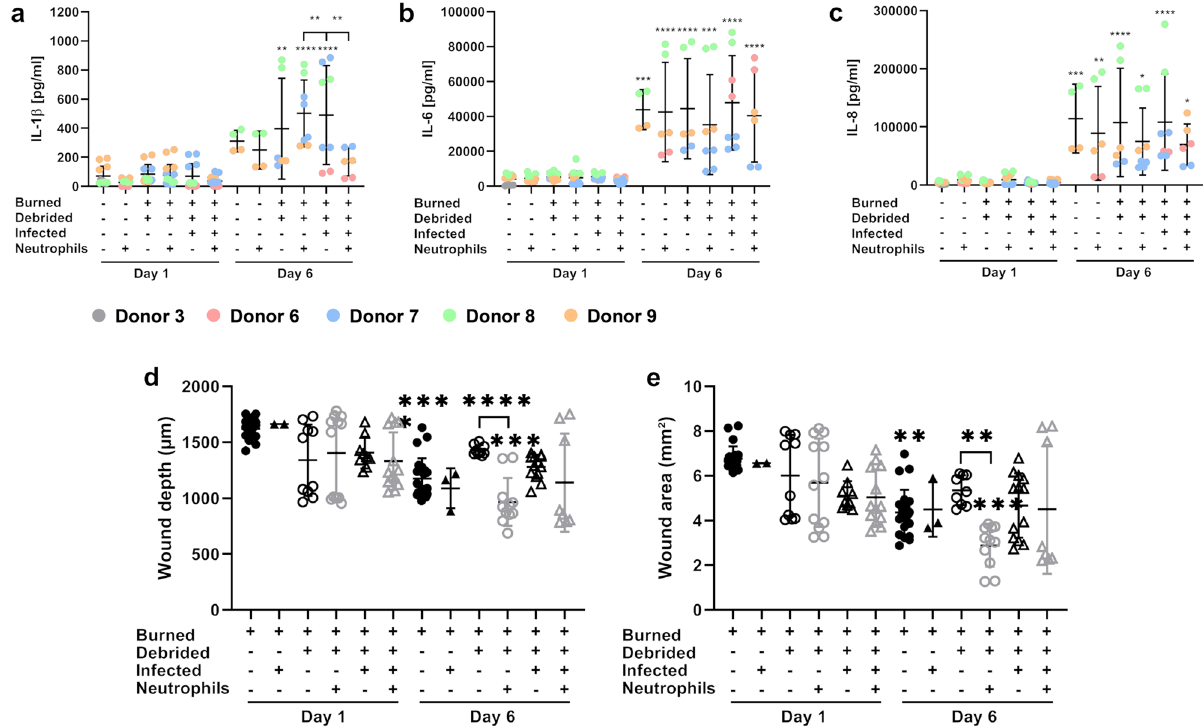
Figure 7. Wound area and depth are decreasing over time paralleled by progressing cytokine release. From day 1 to day 6 cytokine release increases over time ( a – c ), whereas wound area ( d ) and depth ( e ) tend to decrease. For IL-1β, debridement further increases cytokine release ( a ) whereas for IL-6 and IL-8 debridement has no influence ( b , c ). For IL-6 and IL-8, there is a tendency towards reduced cytokine release following neutrophil supplementation although this difference is not significant ( b , c ). If skin tissues are infected, debrided or both, neutrophil supplementation partially reduces wound area ( d ) and wound depth ( e ). For number of skin donors and technical replicates see Table S1. Colors represent various donors ( a – c ). Symbols are as follows: filled triangle, filled circle = non-debrided vs. open triangle, open circle = debrided, filled circle, open circle = non- infected vs. filled triangle, open triangle = infected, black = without neutrophil supplementation vs. grey with neutrophil supplementation ( d , e ). One-way ANOVA with Tukey’s post-hoc test testing day 1 vs. day 6 (asterisks without brackets) and without vs. with neutrophils (asterisks with brackets). Levels of significance: *p < 0.05, **p < 0.01, ***p < 0.001, ****p <